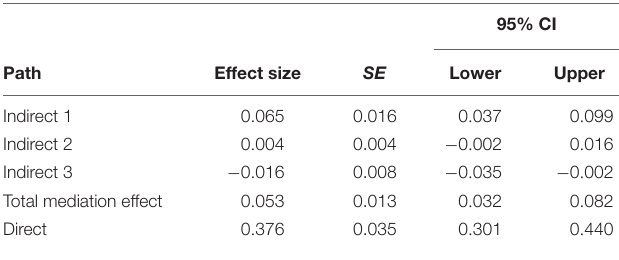
TABLE 2 | Testing the pathways of the multiple mediation